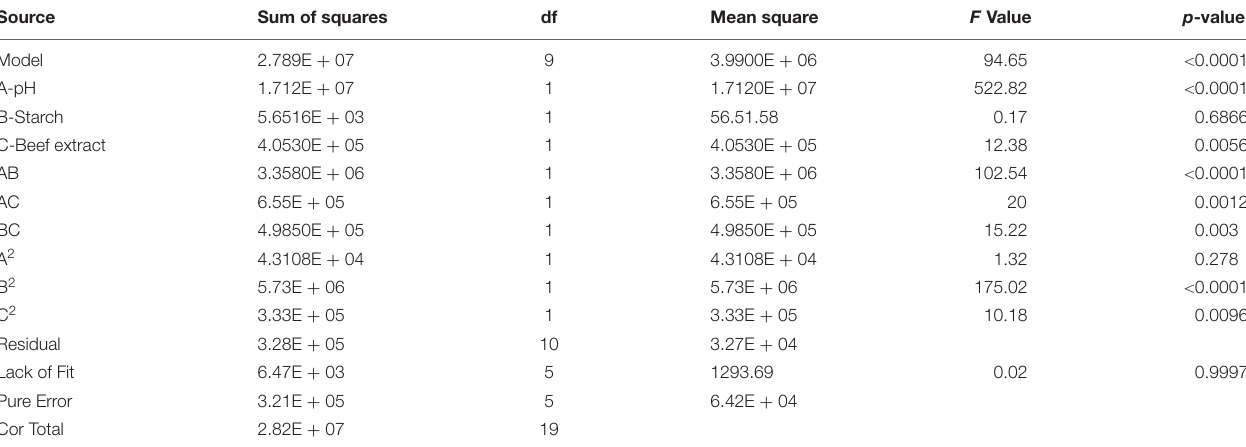
TABLE 3C | Analysis of variance for response surface quadratic model of fibrinolytic enzyme production from Bacillus sp. IND7. Source Sum of squares df Mean